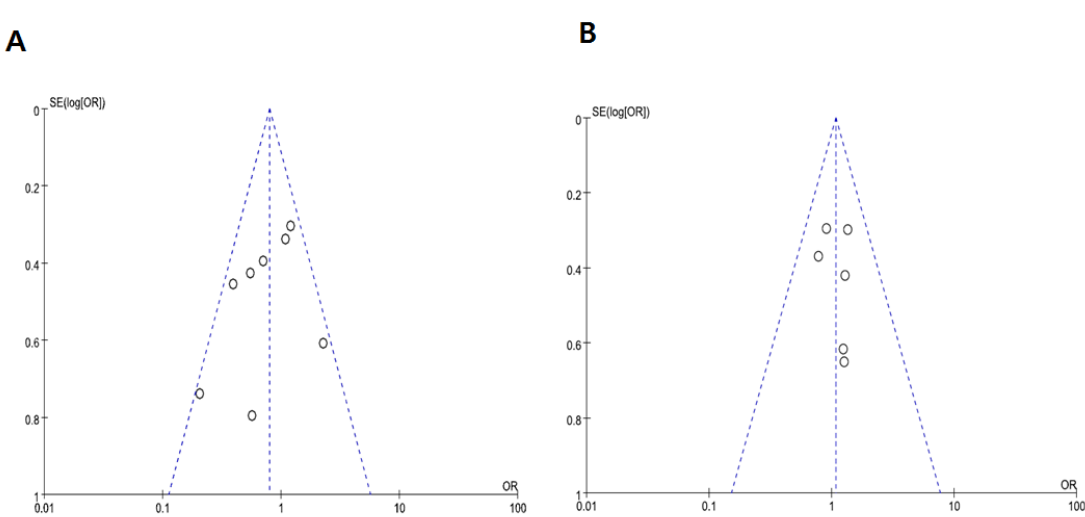
Figure 4. Funnel plots for publication bias. ( A ) Nuclear grade. ( B ) Disease stage.